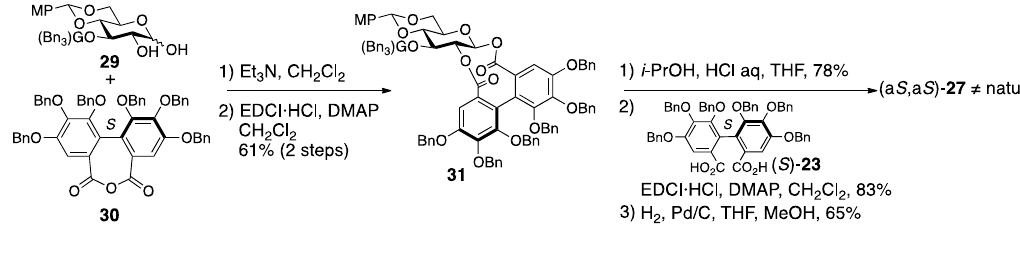
Figure 15. The synthesis of (a S ,a S )- 27 .